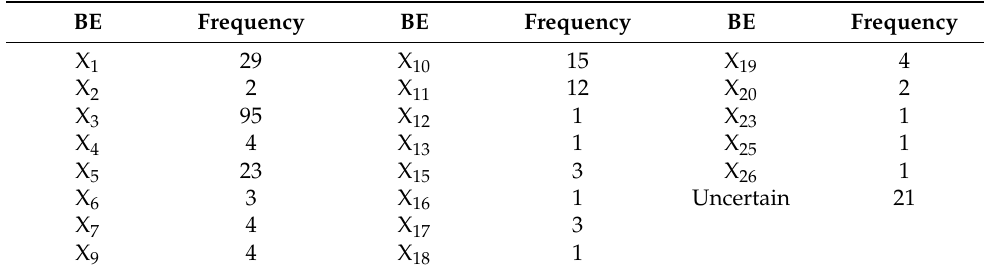
Table 7. The result of the frequency